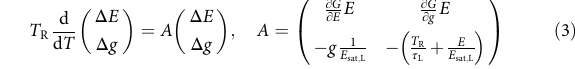
normal CQN device, the fraction of power lost to SHG increases according to α (cid:3) 1 = ð Δ k Þ 2 . Such losses resemble an inverse saturable absorption in the laser, limiting the nonlinearity available before modelocked operation is destabilized. This issue is especially critical at high repetition rates, where large nonlinearities are required due to the low intracavity pulse energy. We have developed a new technique to suppress these losses: adiabatic excitation of quadratic solitons 33 . In this technique, the QPM period is rapidly but smoothly moved far from phase-matching at the input and output sides of the device. In this way, the second-harmonic light, which mediates the large effective nonlinear refractive index, is adiabatically switched “ on ” via the input segment, is large in the middle segment (leading to a large and negative n 2,eff in that segment), and is switched “ off ” via the output segment, as illustrated in Fig. 2 of the main text. With this technique, the resulting nonlinear losses can be decreased by an order of magnitude or more compared to a non-apodized device 33 . The nonlinear chirp QPM pro fi les used are analogous to apodization in chirped QPM devices 42, 43 , where they ef fi ciently excite adiabatic three-wave mixing processes 44 . PPLN operating point . In our PPLN device, the value of the grating k -vector K g in the interaction region (as indicated in Fig. 2a) varies continuously across the transverse position in the device (i.e. perpendicular to the beam propagation direction). This value varies from 854 to 934mm − 1 across the transverse pro fi le of the device. The three example operating points depicted in Fig. 2a and the cor- responding values of n 2 ,eff in Fig. 2b illustrate the trade-offs involved in optimizing modelocking performance. When operating closer to position (1) (large phase- NATURE COMMUNICATIONS | 8:1673 | DOI: 10.1038/s41467-017-01999-y |